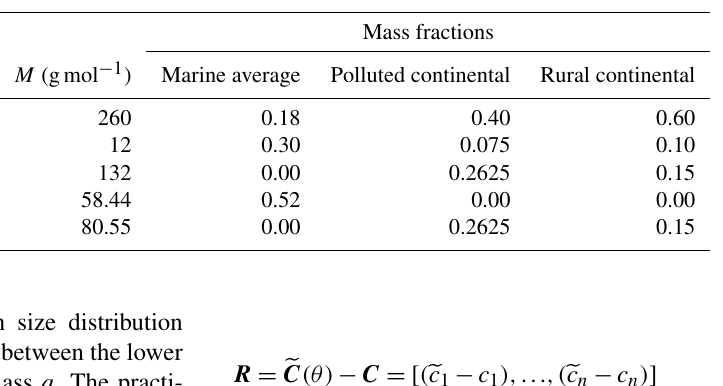
Table 1. Density, molecular weight, and mass fraction of each aerosol component in all environments. The mass fractions included here are used to derive true parameter values for f insol and α in Table